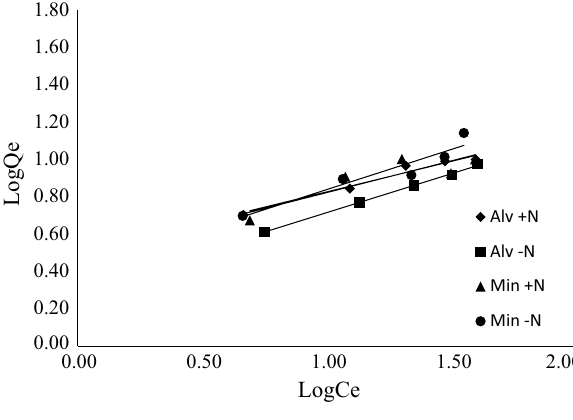
Fig. 15 Freundlich isotherm for nickel ions onto N. alveolaris + N, N. alveolaris –N, N. minuta + N, and N/ minuta –N